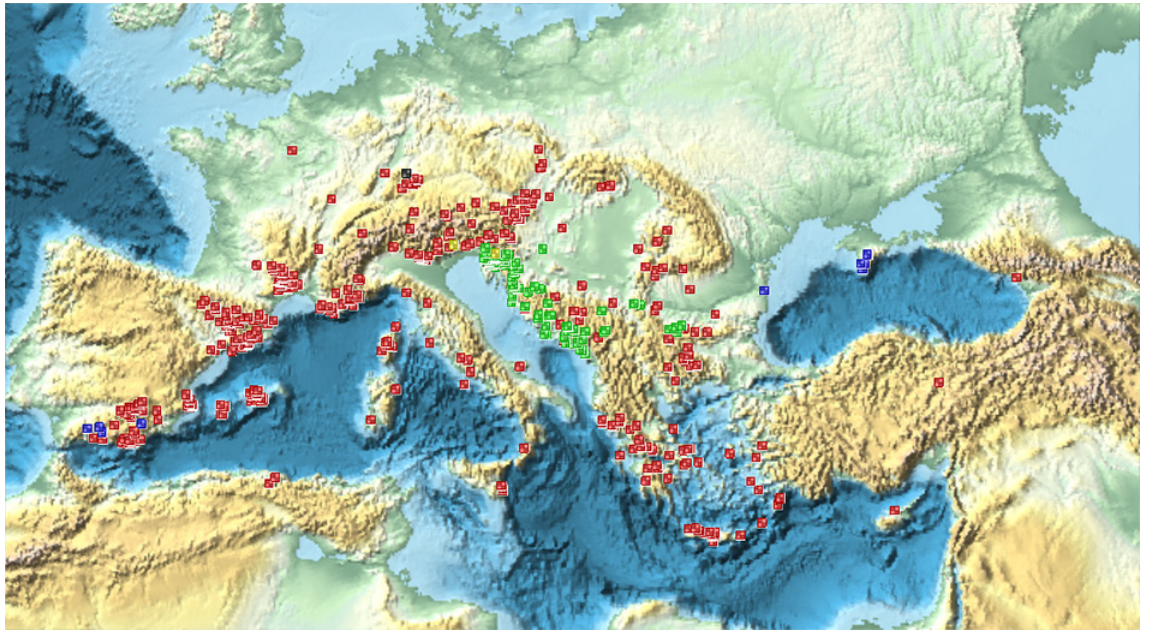
Fig. 211. Distribution map of subgenera of Plusiocampa Silvestri, 1912: Dydimocampa Paclt, 1957 (blue squares), Pentachaetocampa Sendra & Weber, 2018 (black square), Plusiocampa s. str. (red squares), Stygiocampa Silvestri, 1934 (green squares) and Venetocampa Bareth & Condé, 1984 (yellow squares).